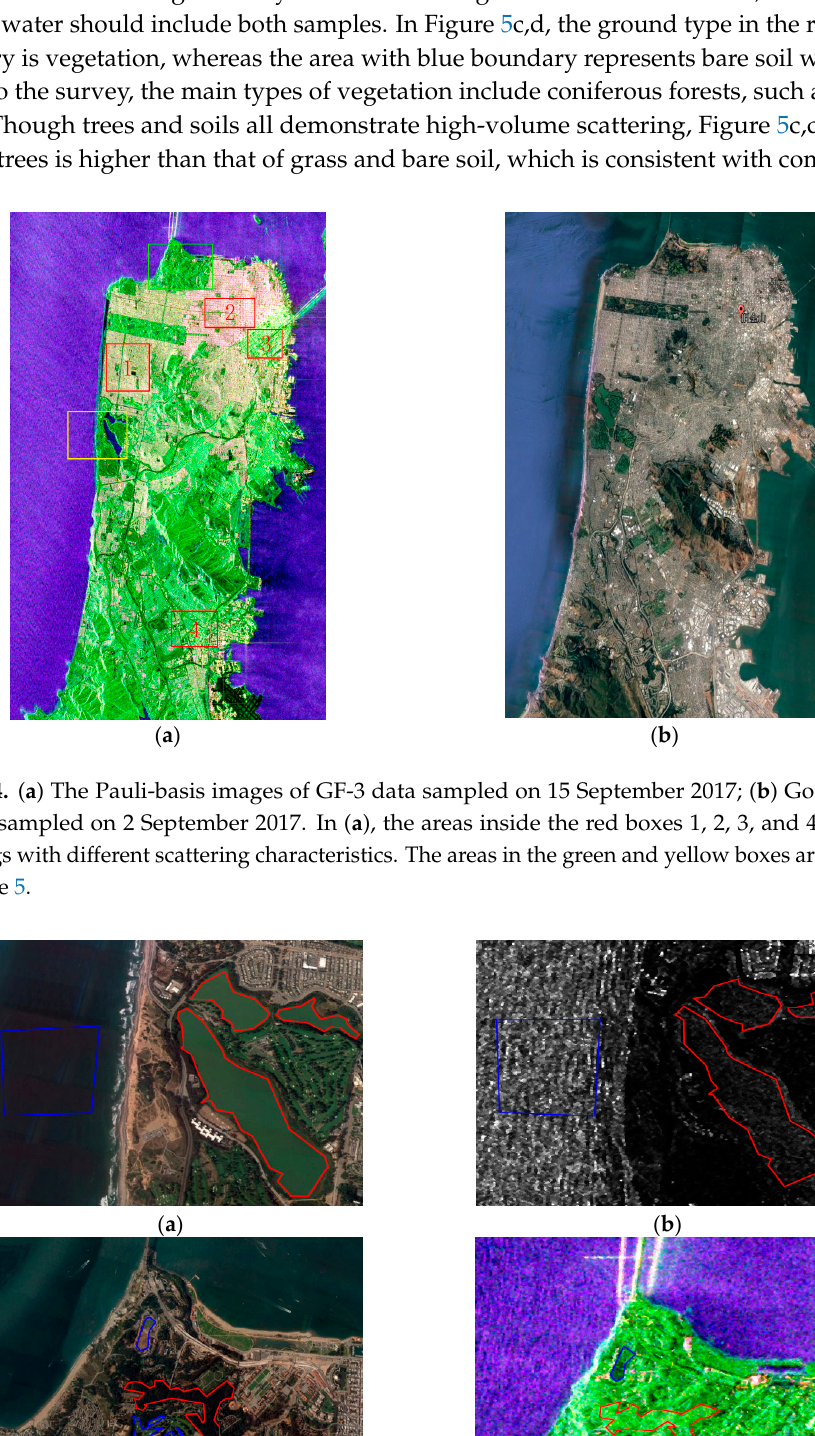
Figure 3. The proposed classification procedure on Chinese Gaofen-3 (GF-3).